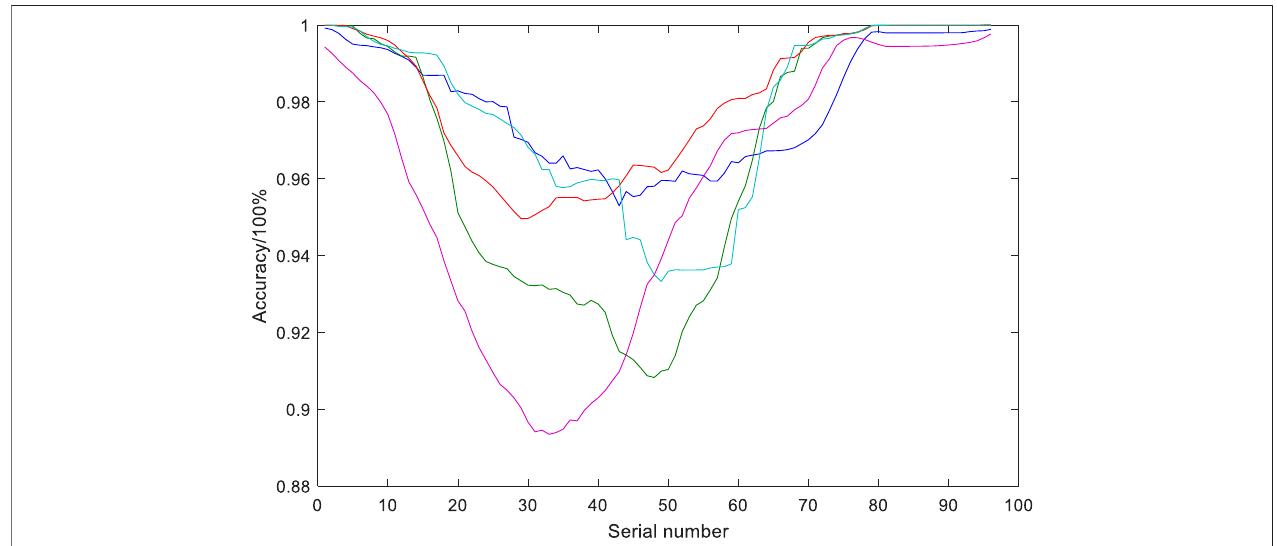
FIGURE 6 | Daily prediction accuracy curves for the 5 days with the highest daily average prediction accuracy.